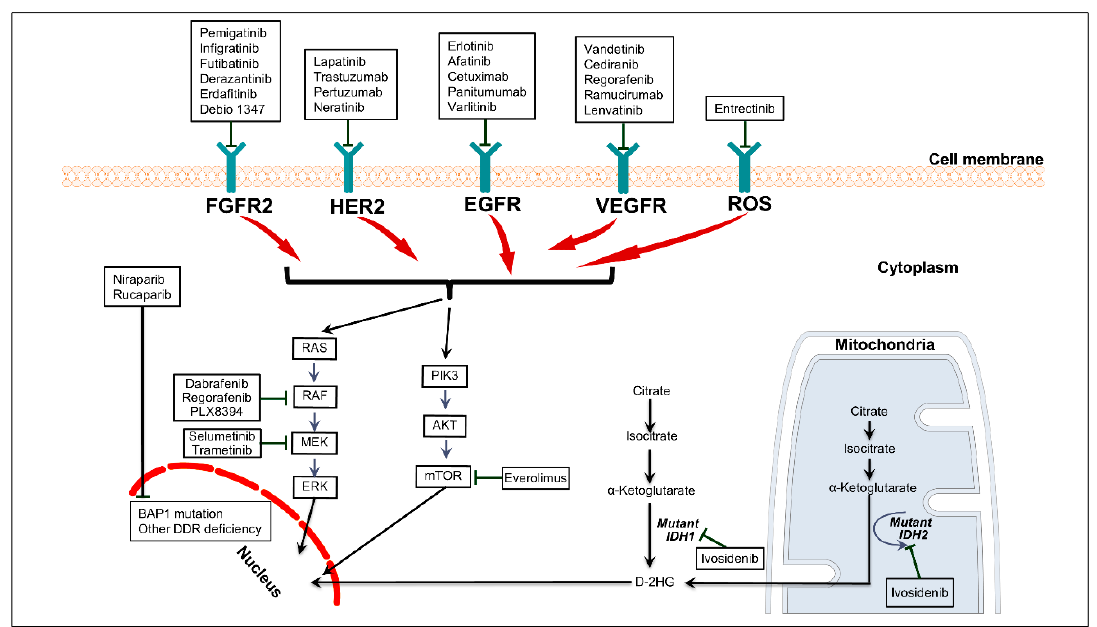
Figure 1. Interactions among the therapeutically relevant signaling pathways in biliary tract cancer and therapies available to target those pathways. Abbreviations: DDR, DNA damage repair; 2-HG, 2-hydroxyglutarate.